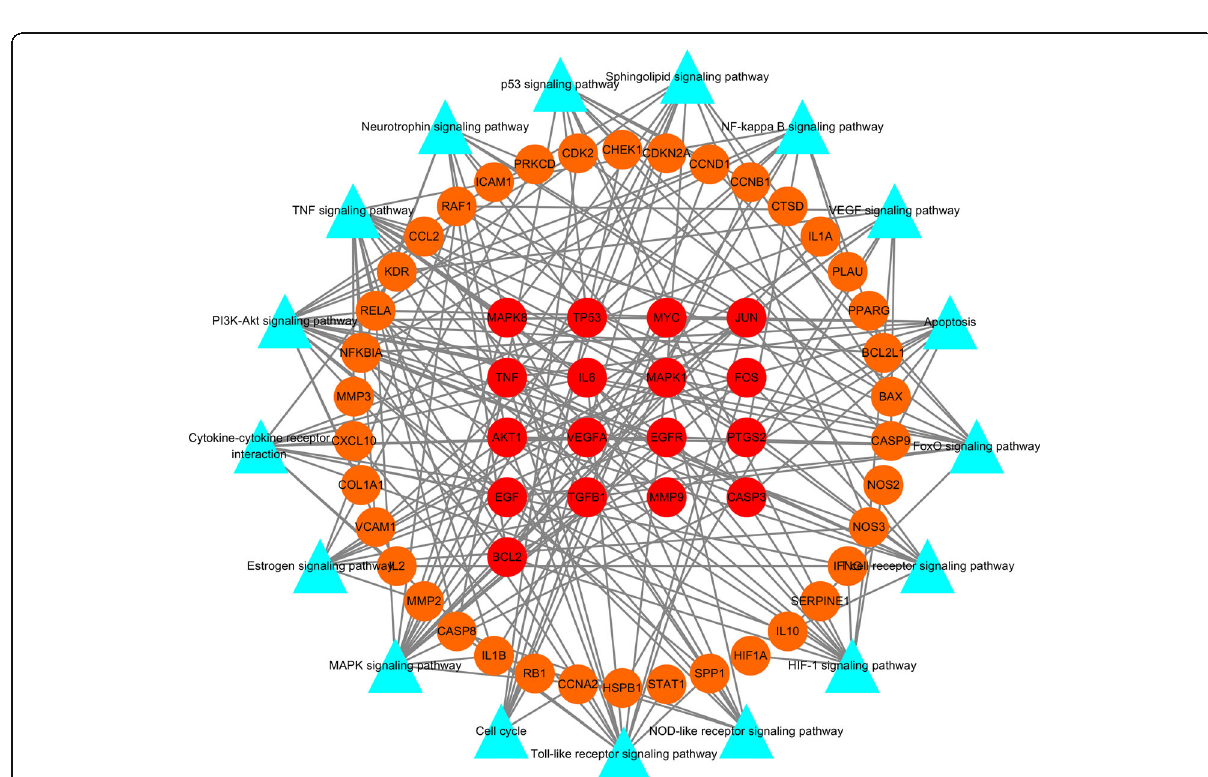
Fig. 8 Target-Pathway Network. The red round nodes represent the big hub nodes, the orange round nodes represent the other nodes. The blue triangles represent the related